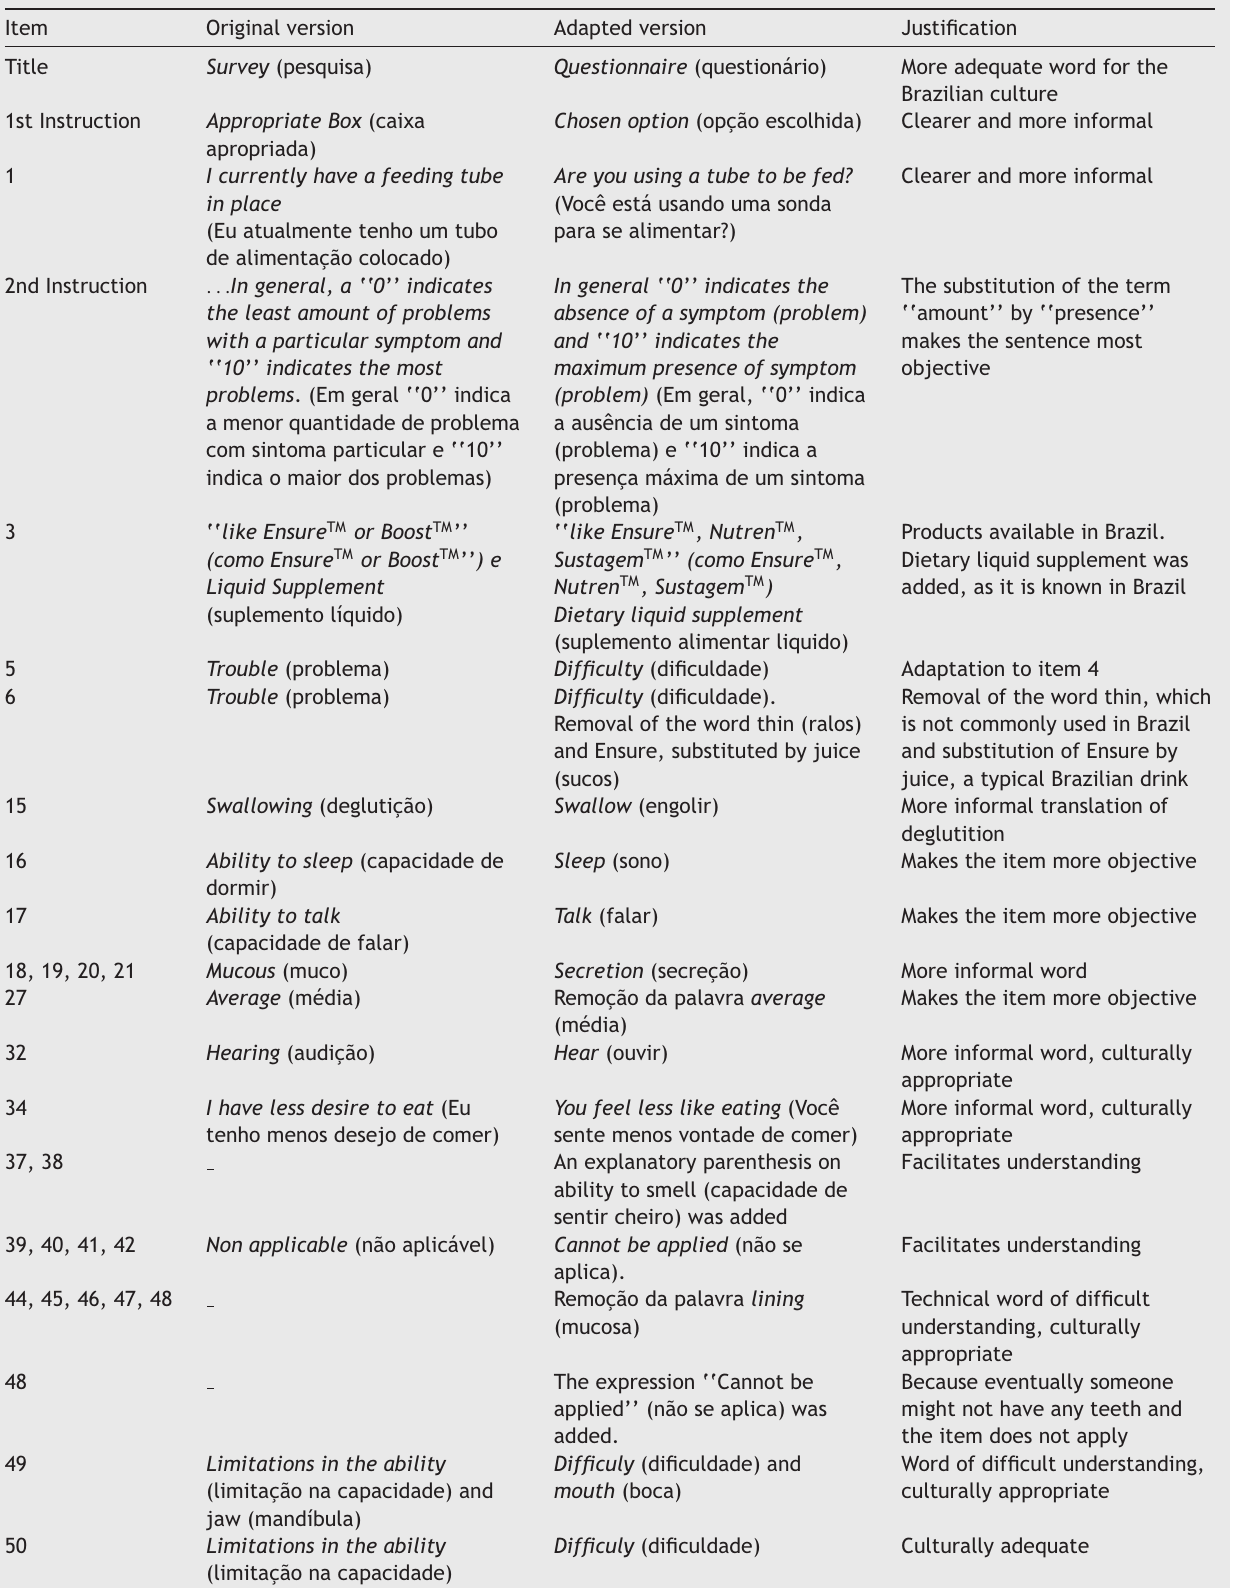
Modifications suggested for VHNSS 2.0 items by the expert committee and